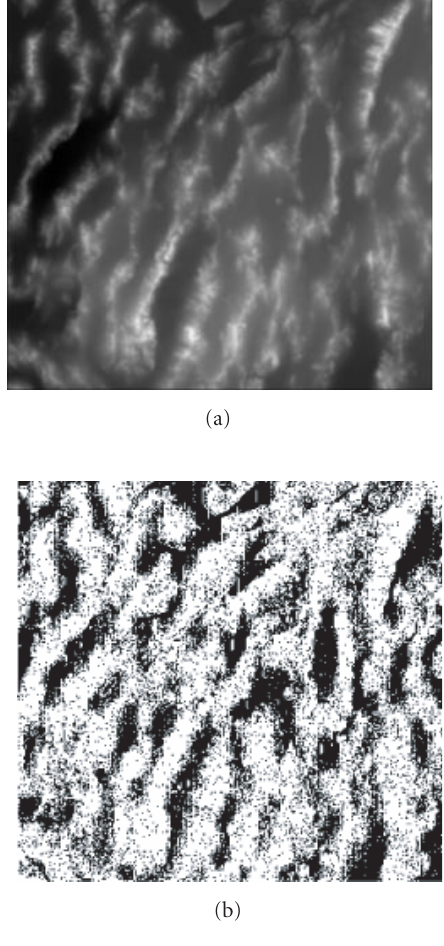
Figure 5.1. DEM smoothening using Gaussian blurring. (a) The smoothened DEM. (b) The mask of pixels modified by Gaussian